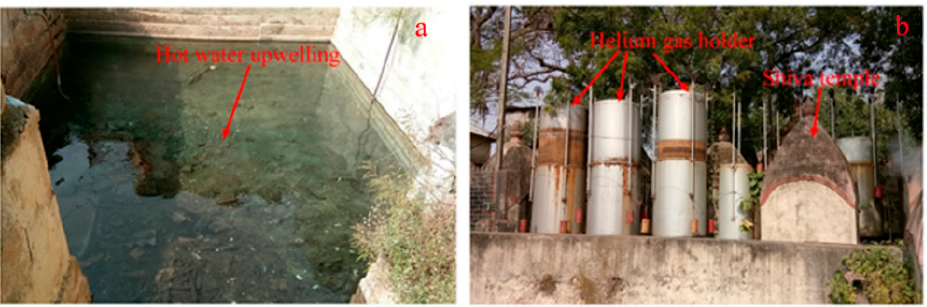
Figure 10. ( a ) Agni kunda hot spring. ( b ) Helium gas holder (Source: Field Photographs, 2021).